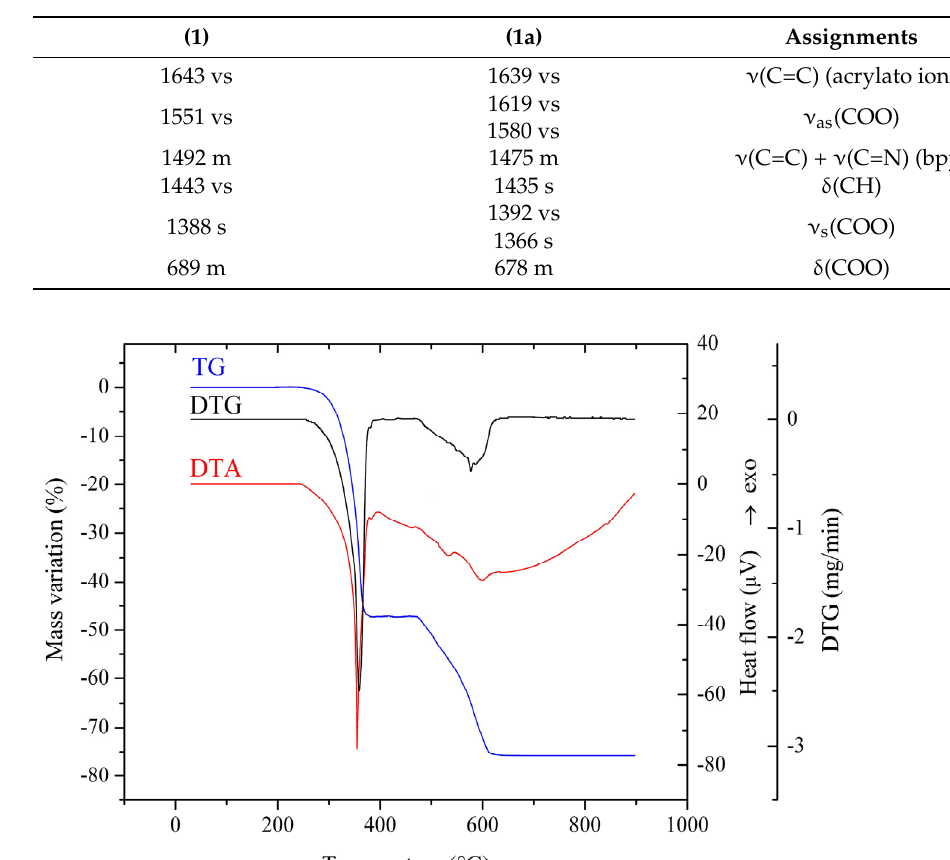
Figure 4. Thermogravimetric analysis of coordination polymer [Zn(bpy)(acr)(HCOO)] n ( 1a